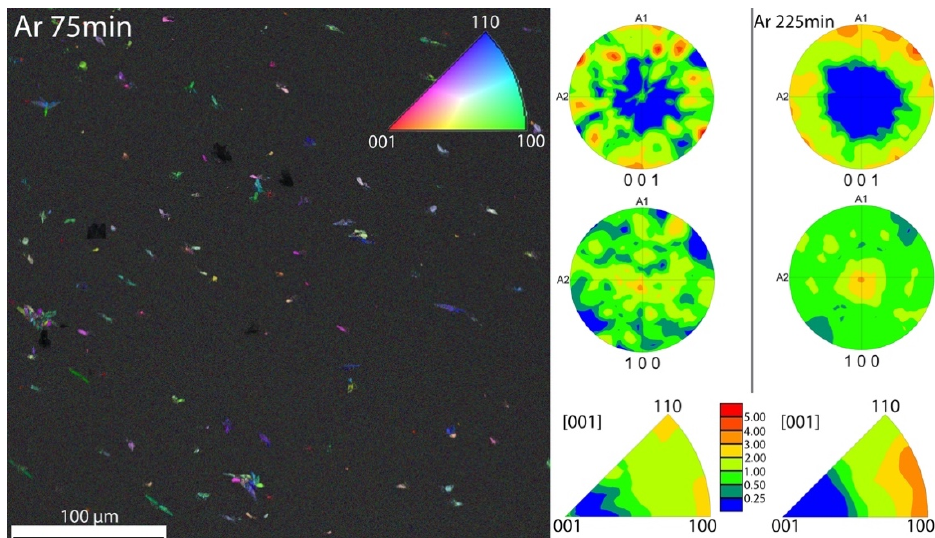
Figure 9. Texture and orientation data for a sample heat-treated in argon. Left: 001 inverse pole figure mapping, 100 and 001 pole figures and [001] inverse pole figure of the texture. Right column: Comparison with texture data obtained from a sample heat-treated for 225 min in argon atmosphere, obtained by cropping a similar-sized region of interest from the dataset shown in Figure 8.